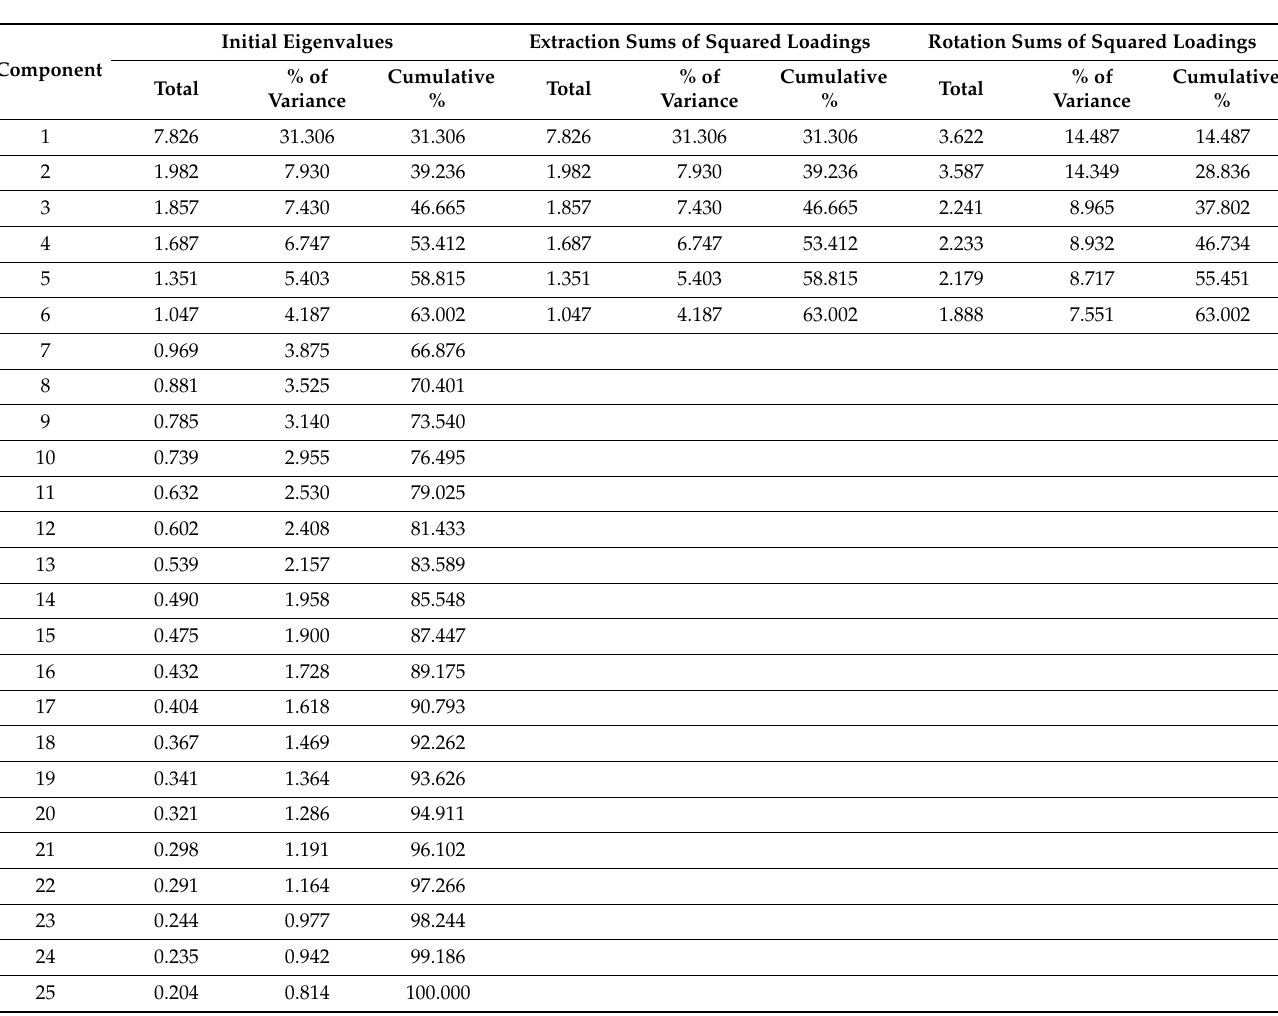
Table 4. Total variance explained (Independent